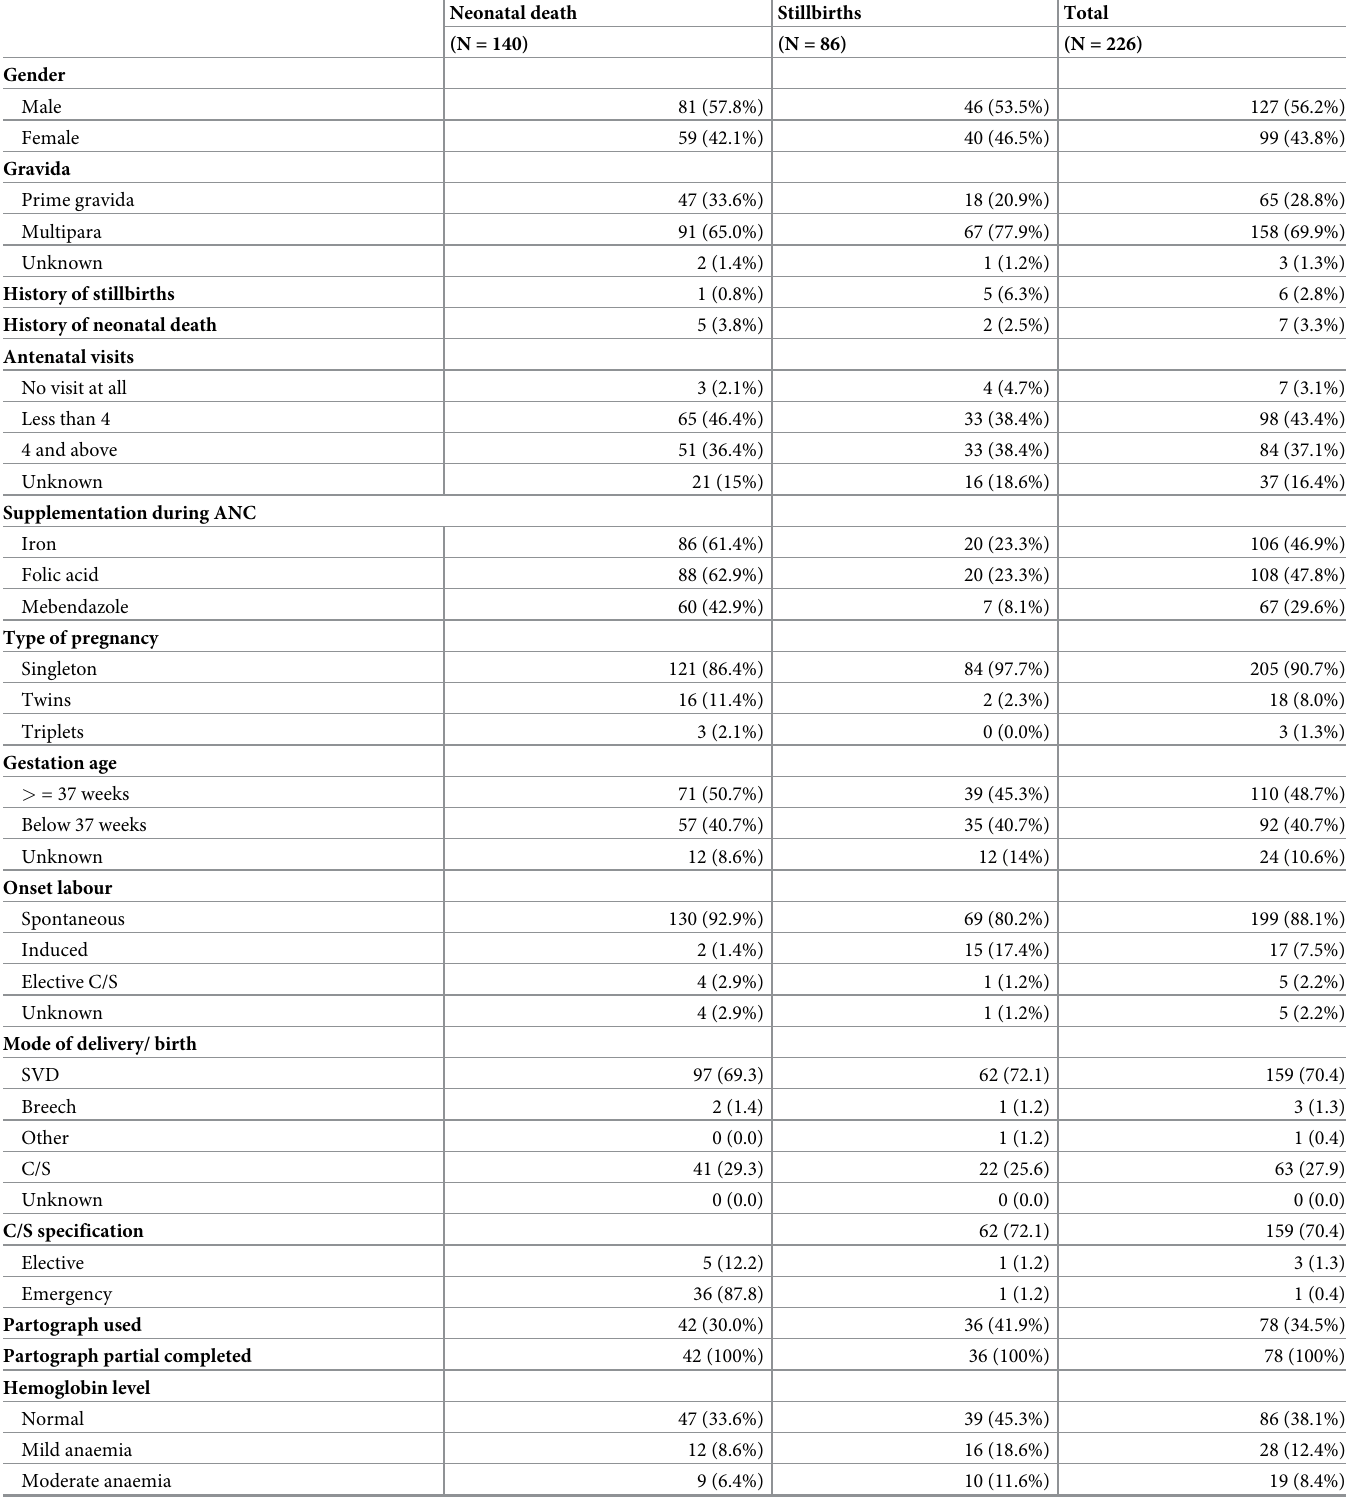
Table 2. Distribution of maternal characteristics by baby